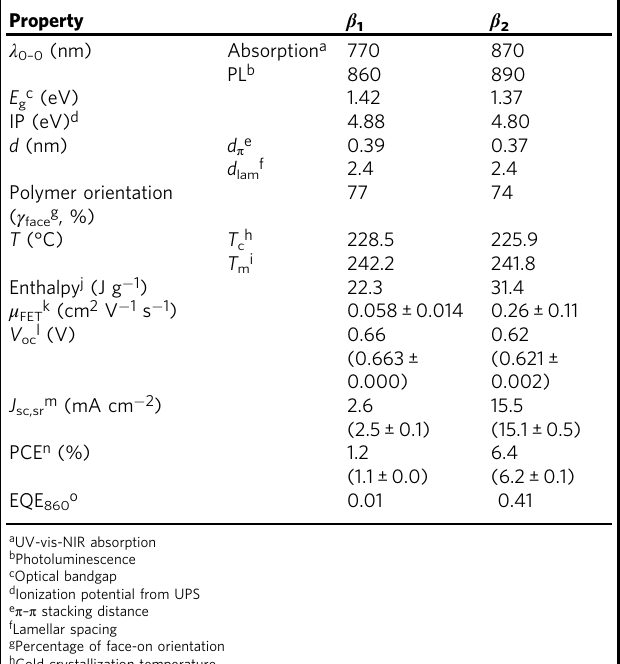
Table 1 Optical, structural, thermal, and electrical